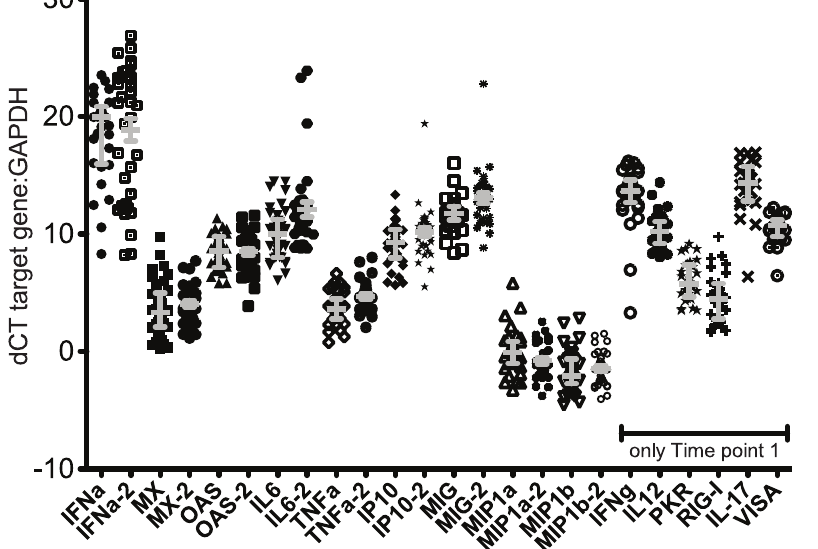
Figure 1. Concentration of all mRNAs (relative to GAPDH) in vaginal secretions collected between menstrual cycle days 10–20 from 36 RM at Time point 1 (March 2011) and from 30–35 RM at Time point 2 (November 2011). The samples collected at Time point 2 are denoted by the notation ‘‘ 2 2’’. All vaginal secretions were collected between menstrual cycle days 10–20. Note that there was not enough CVS sample at Time point 2 to assess all mRNA targets that were tested at Time point 1. Grey bars denote median and interquartile range of the values.